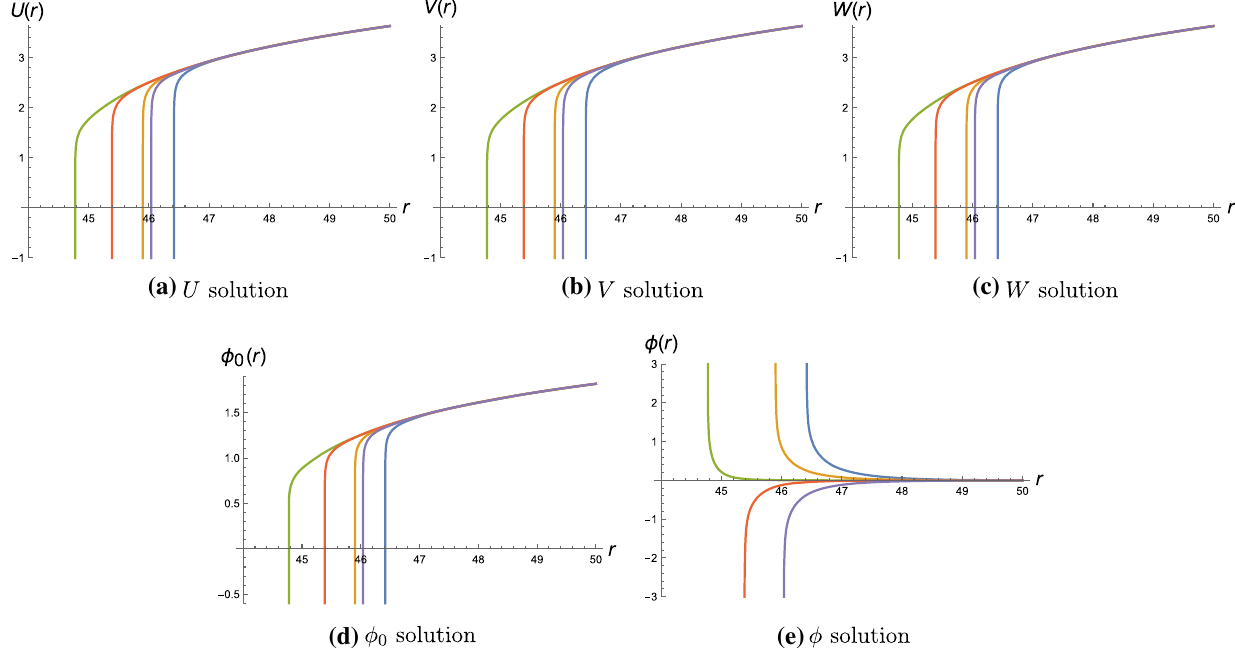
Fig. 39 Supersymmetric flows interpolating between asymptotically locally flat domain walls and Mk w 2 × S 2 × R 2 -sliced curved domain walls in SO ( 4 ) gauge group. The blue, orange, green, red and purple curves refer to p 21 = − 0 . 5 , − 0 . 12 , 0 . 03 , 0 . 06 , 0 . 25,